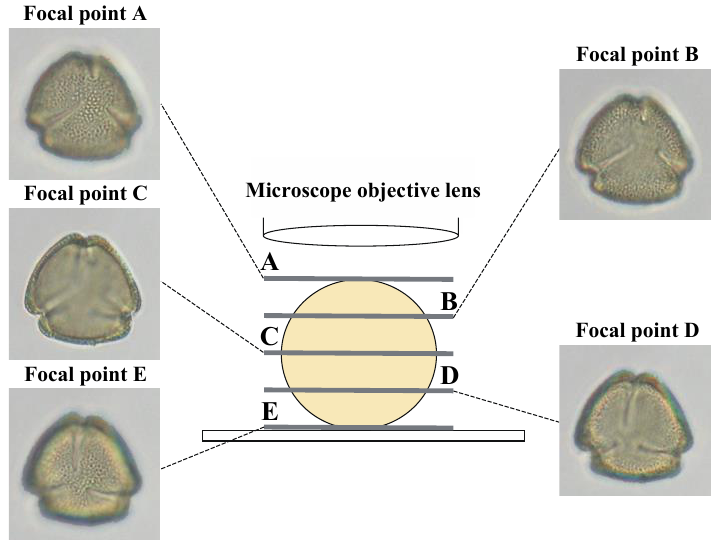
Figure 2. Differences among captured images according to focal point position.